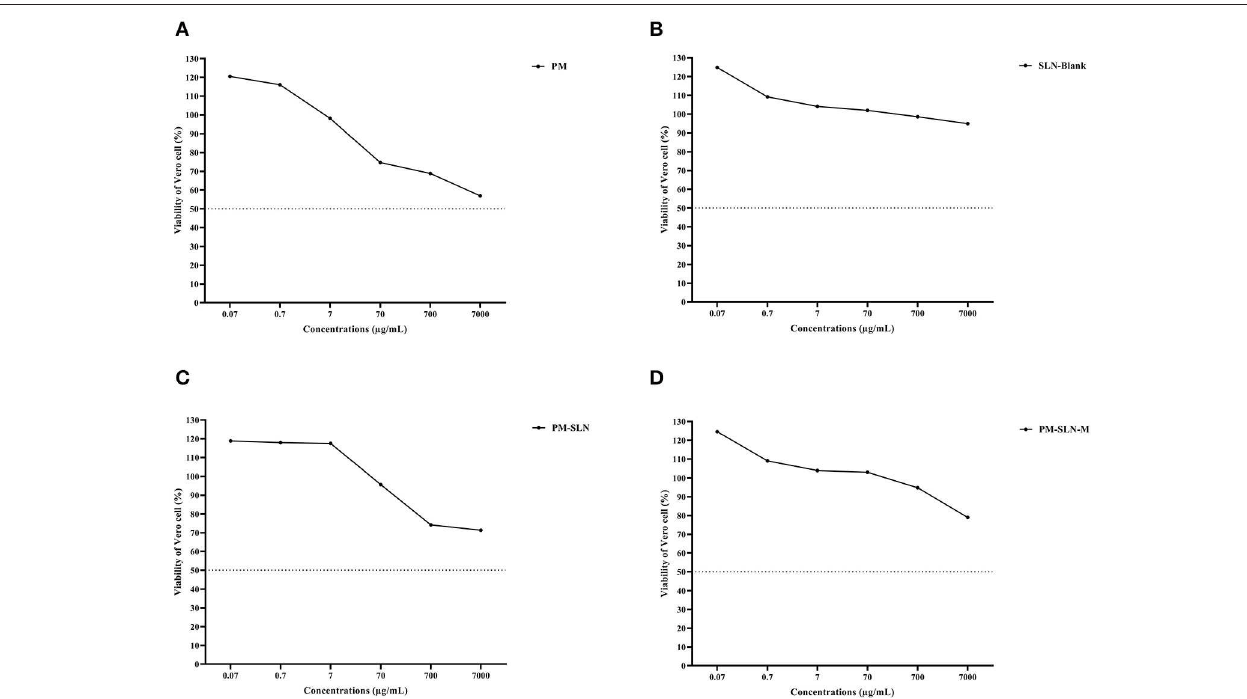
FIGURE 3 | Cell toxicity assay of (A) PM, (B) SLN-BLANK, (C) PM-SLN, and (D) PM-SLN-M on Vero cell line.